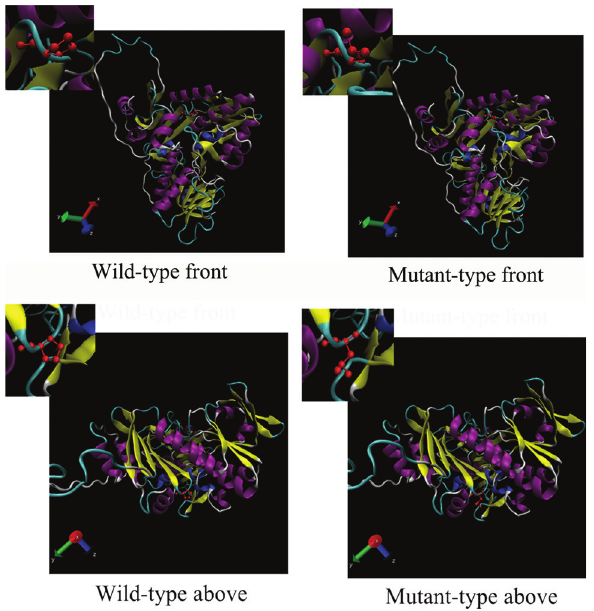
Figure 2 - Three-dimensional structure of wild-type and mutant AIFM1. The crystal structure of mutant AIFM1 was constructed using the Swiss Model platform with the template of wild-type monomeric human